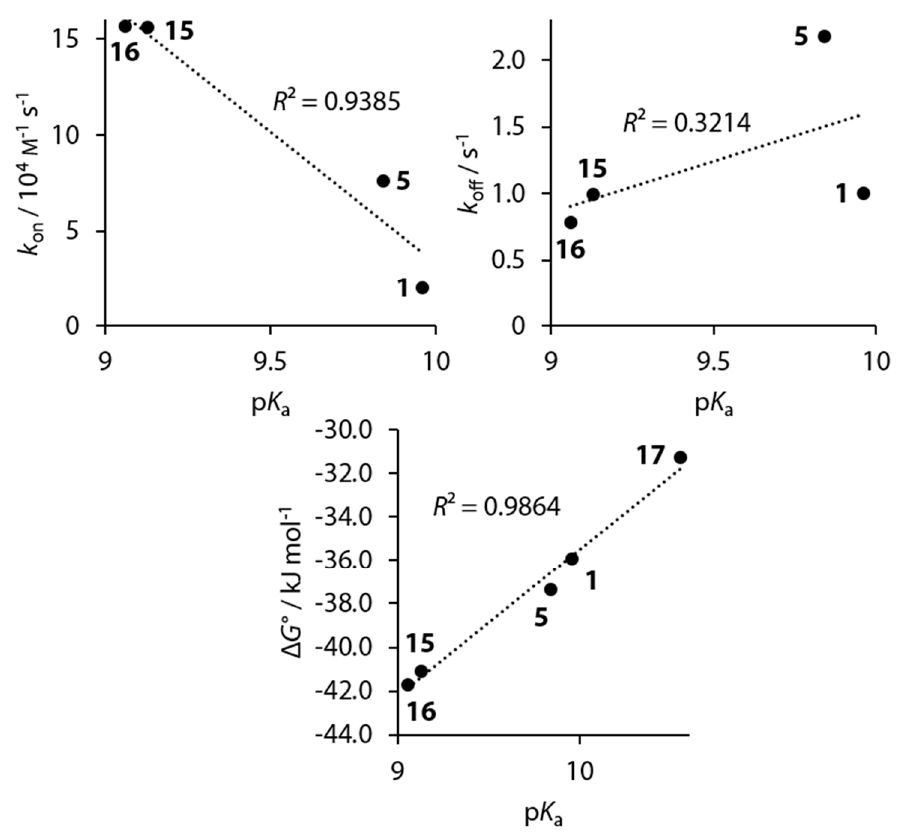
Figure 14. Plots of k on and k off of compounds 1 , 5 , 15 , and 16 and plot of Δ G ° of compounds 1 , 5 , 15 , 16 , and 17 against the p K a value.